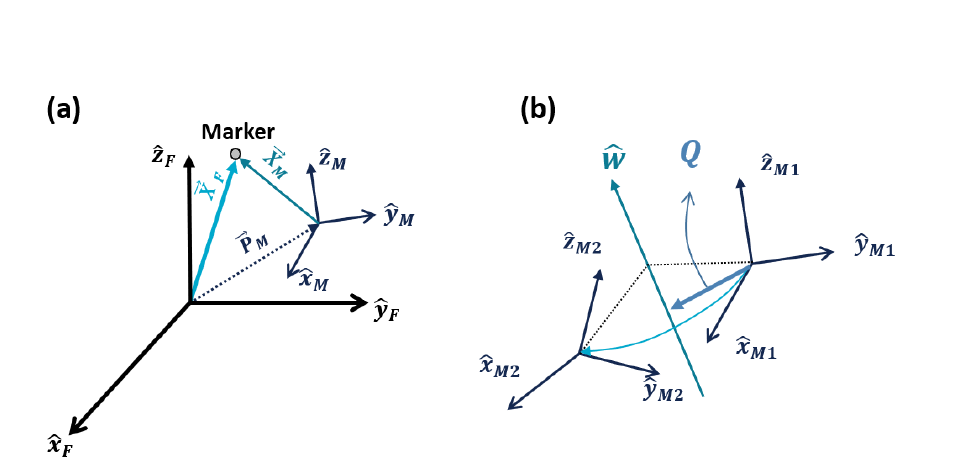
Figure 7. Schematic view to explain the transformation and rotation of